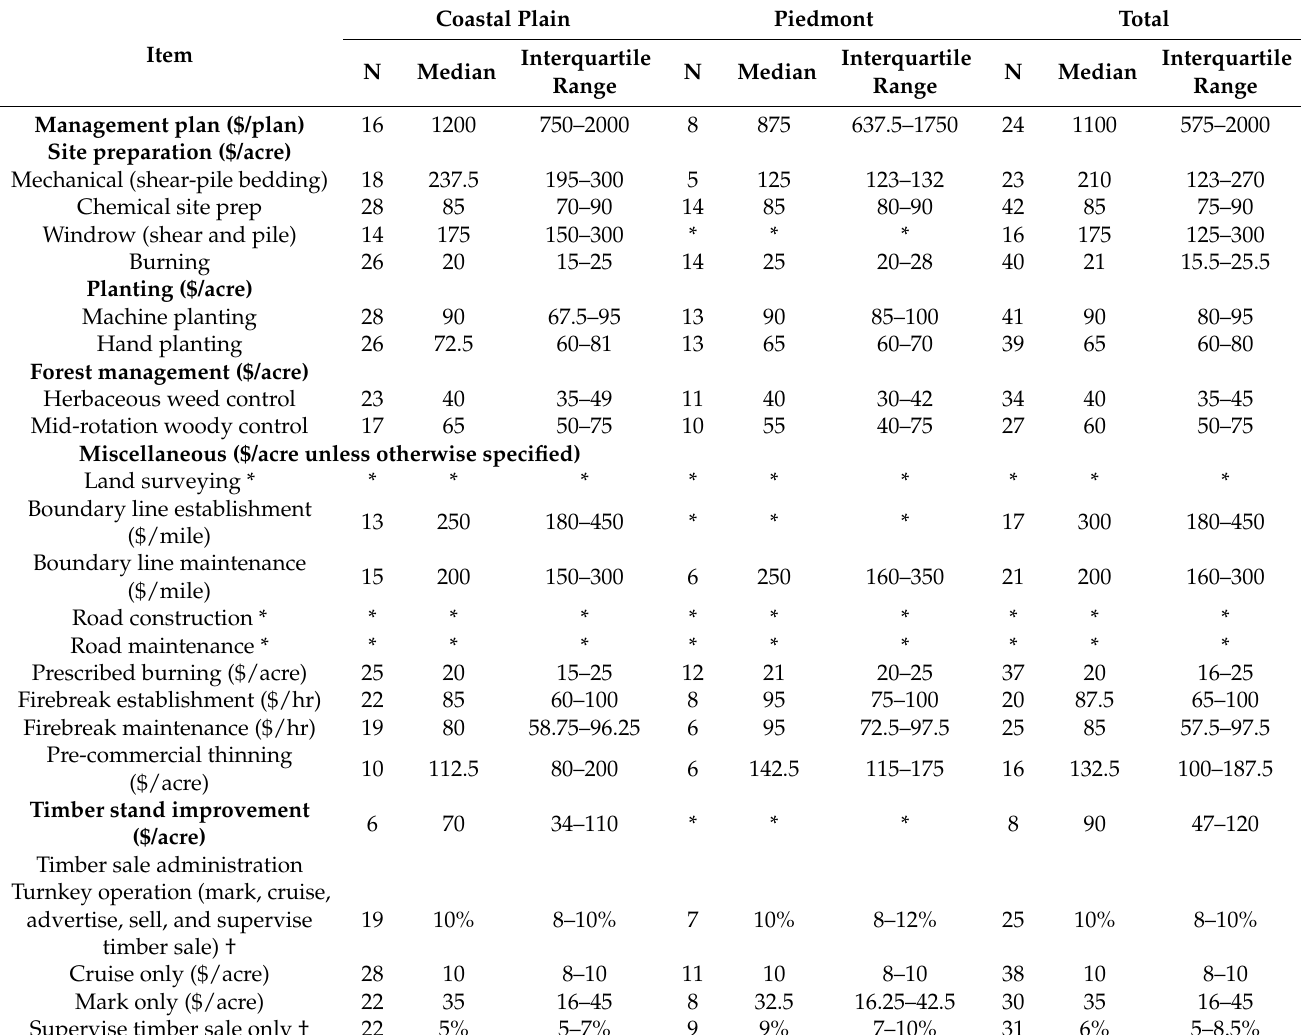
Table 3. Estimated unit forest management costs for a hypothetical 100-acre pine tract by region and type ($/acre unless otherwise